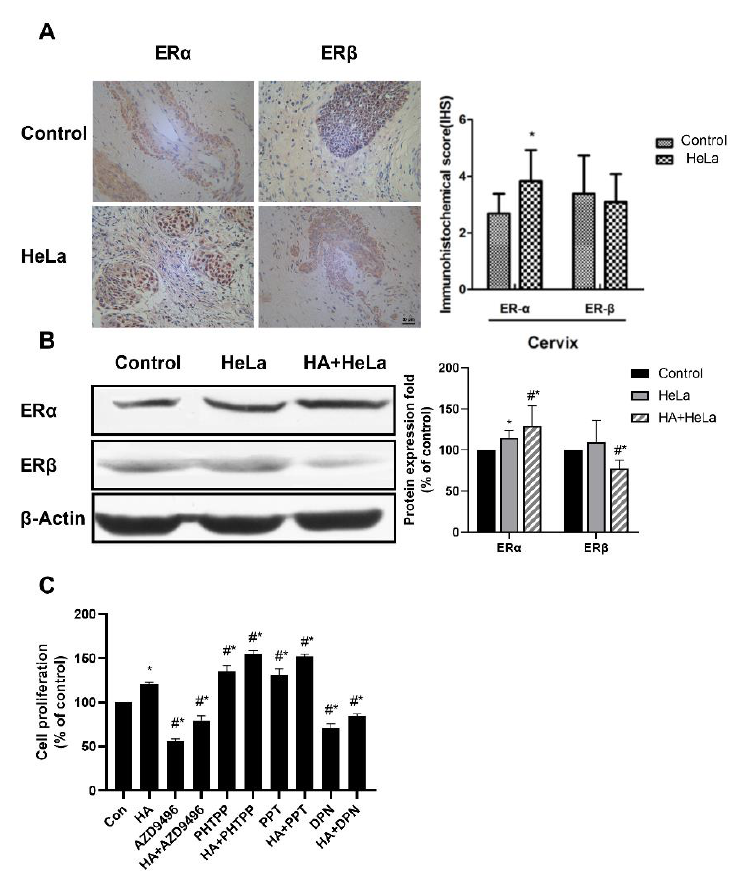
Figure 2. Histamine induced tumor growth by altering the expression level of the estrogen receptors (ERs). The expression of ERα was promoted after treatment with histamine, while ERβ showed the opposite results. ( A ) Immunohistochemistry detection of ER expression in the cervical tissue of the control group and HeLa group. ( B ) Western blot analysis of the expression levels of ERα and ERβ from respective tumor tissues. The results are expressed as a percentage of control, which is set at 100%. The antibodies used in this experiment were ERα (ab32063) and ERβ (ab288) ( C ) Effects of four kinds of ER modulator (AZD9496, PHTPP, PPT and DPN) and HA on HeLa cell proliferation, HeLa cells were incubated with these reagents at the concentration of 1 μM and the fortification concentration of HA was 50 ng/mL. All cells were incubated with histamine and ER modulators for 48h before the proliferation percentage was measured. Cas registry number for ER modulators: AZD9496 (CAS No.: 1639042-08-2), PHTPP (CAS No.: 805239-56-9), PPT (CAS No.: 263717-53-9) and DPN (CAS No.: 1428-67-7). Data are presented as the mean ± SEM of at least three independent experiments. * p < 0.05 versus the control group. # p < 0.05 versus the HeLa or HA group